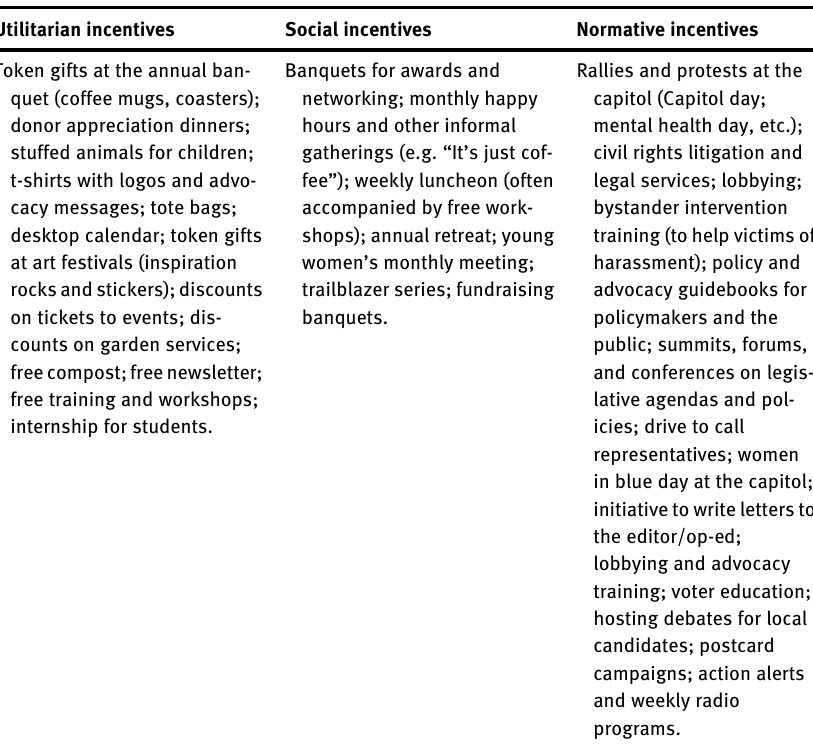
Table  : Examples of the incentives adopted. Utilitarian incentives Social